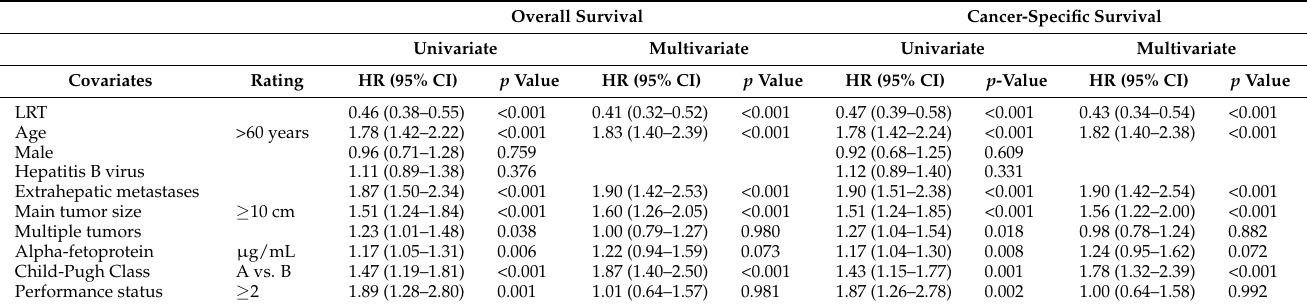
Table 2. Predictors for